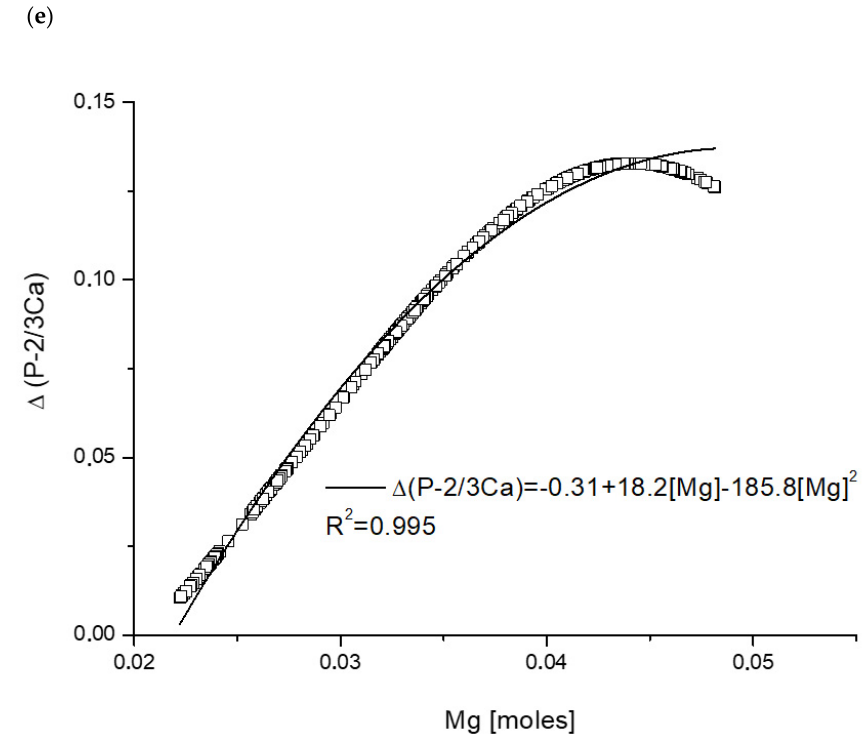
Figure 3. Horse case: ( a ) strictly convergent spatial profiles of inverted Ca/P and Mg; ( b ) correlation between Ca/P and Mg with relevant equation; ( c ) correlation between Ca and P with equation; ( d ) distribution of Ca (*2/3) and P ions as functions of Mg concentration, with addition of similar data for pig; ( e ) variability in the difference of molar amounts of Ca and P as a function of the change in Mg amount.